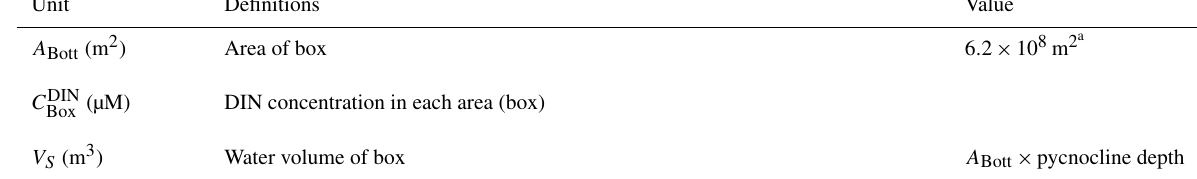
Table 3. Definitions and values used in N mass balance model to calculate DIN removal by biological production.